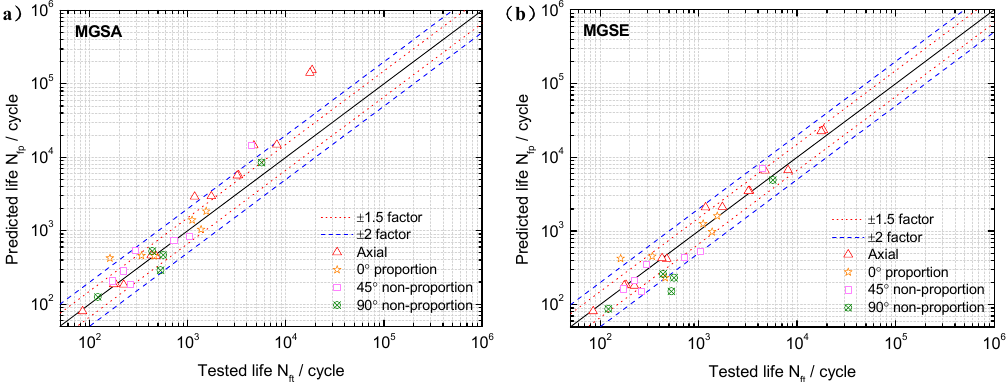
Figure 5. Comparison between tested lives and predicted lives using ( a ) the MGSA model (Equation (10)) and ( b ) the MGSE model (Equation (11)) for GH4169 at 650 ° C.